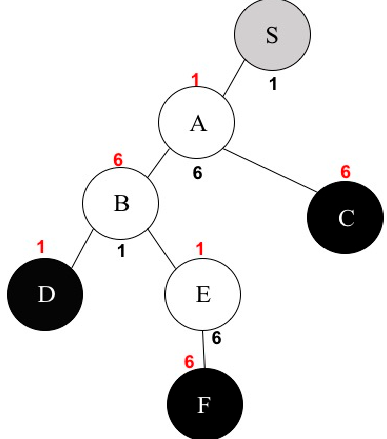
Figure 1. An example of channel assignment by MCM.